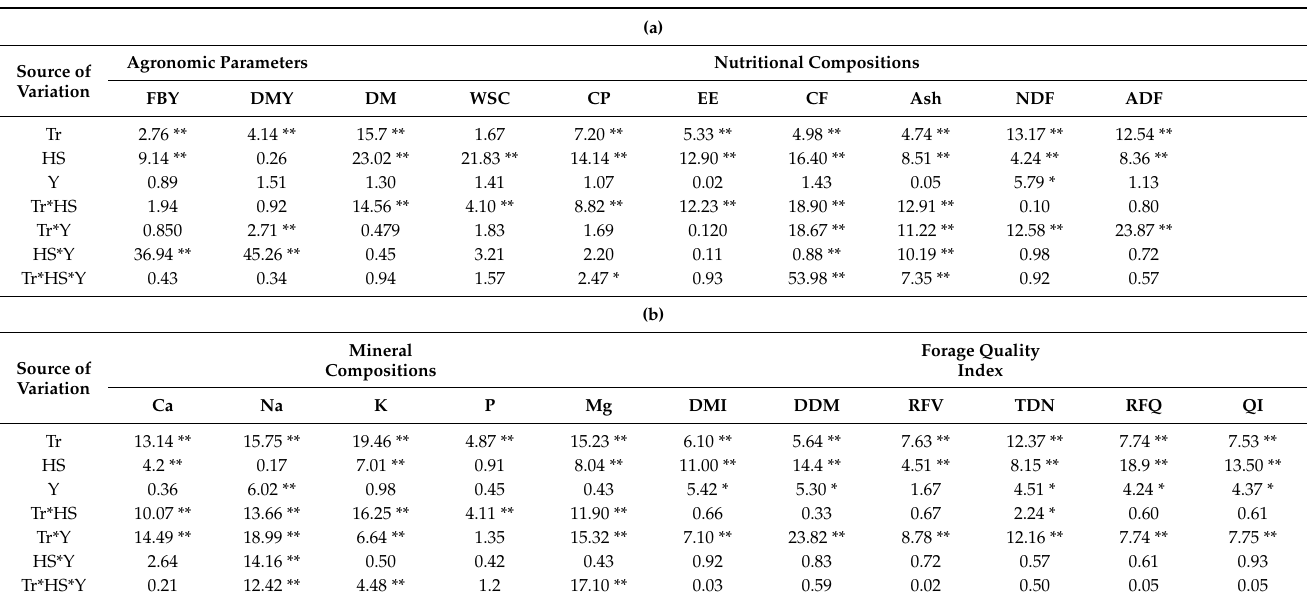
Table 3. ( a ). Analysis of variance on yield parameters, nutritional compositions, mineral compositions, and forage quality parameters during two cropping seasons: 2020–2021 and 2021–2022. ( b ). Analysis of variance on yield parameters, nutritional compositions, mineral compositions, and forage quality parameters during two cropping seasons: 2020–2021 and